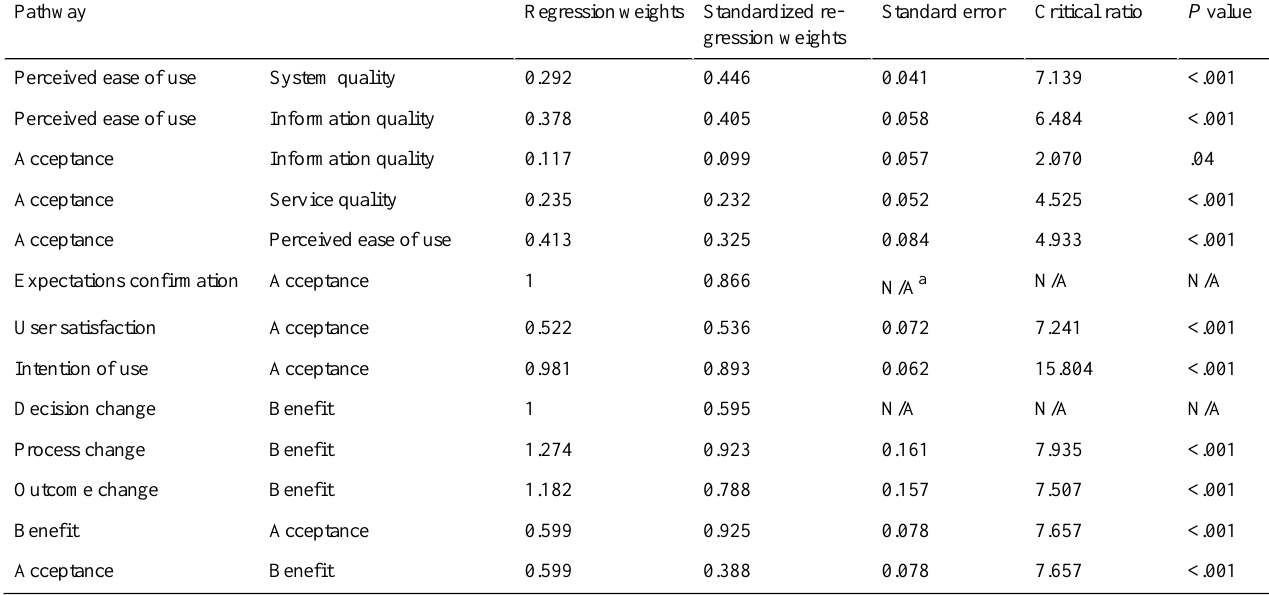
Table 4. Parameter estimation for path coefficients.